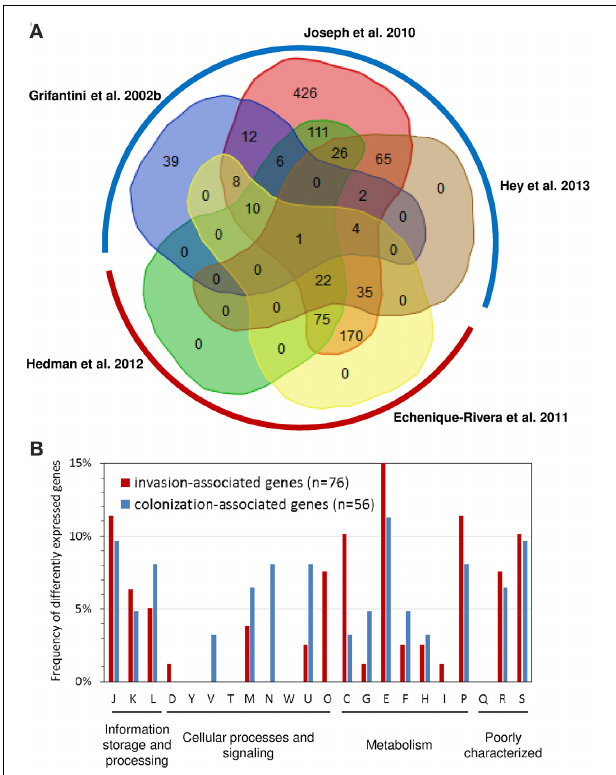
FIGURE 2 | Comparison of transcriptome studies in strain MC58. (A) Venn diagram comparing the sets of genes found to be differently expressed in strain MC58 either upon adhesion to human airway epithelial cells or upon contact with human whole blood. The transcriptomic data describing the colonizing state were taken from Grifantini et al. (2002b); Joseph et al. (2010) and Hey et al. (2013), respectively, and are framed by a blue hemicircle. The data corresponding to the invasive disease state were taken from Echenique-Rivera et al. (2011) and Hedman et al. (2012) and are framed by a red hemicircle. The histogram in panel (B) compares the functional profiles of colonization-associated genes with the functional profile of the invasion-associated genes as defined in the text. The functional classification is based on the COG classification scheme (Tatusov et al., 2001). Abbreviations: C, energy production and conversion; D, cell cycle control, cell division, chromosome partitioning; E, amino